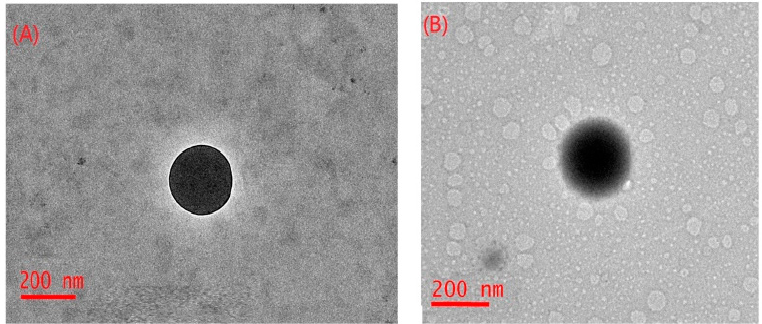
Figure 2. Transmission electron microscopy (TEM) images: ( A ) and ( B ) are poly (lactic-co-glycolic acid) (PLGA) microparticle and chitosan – PLGA microparticle, respectively.